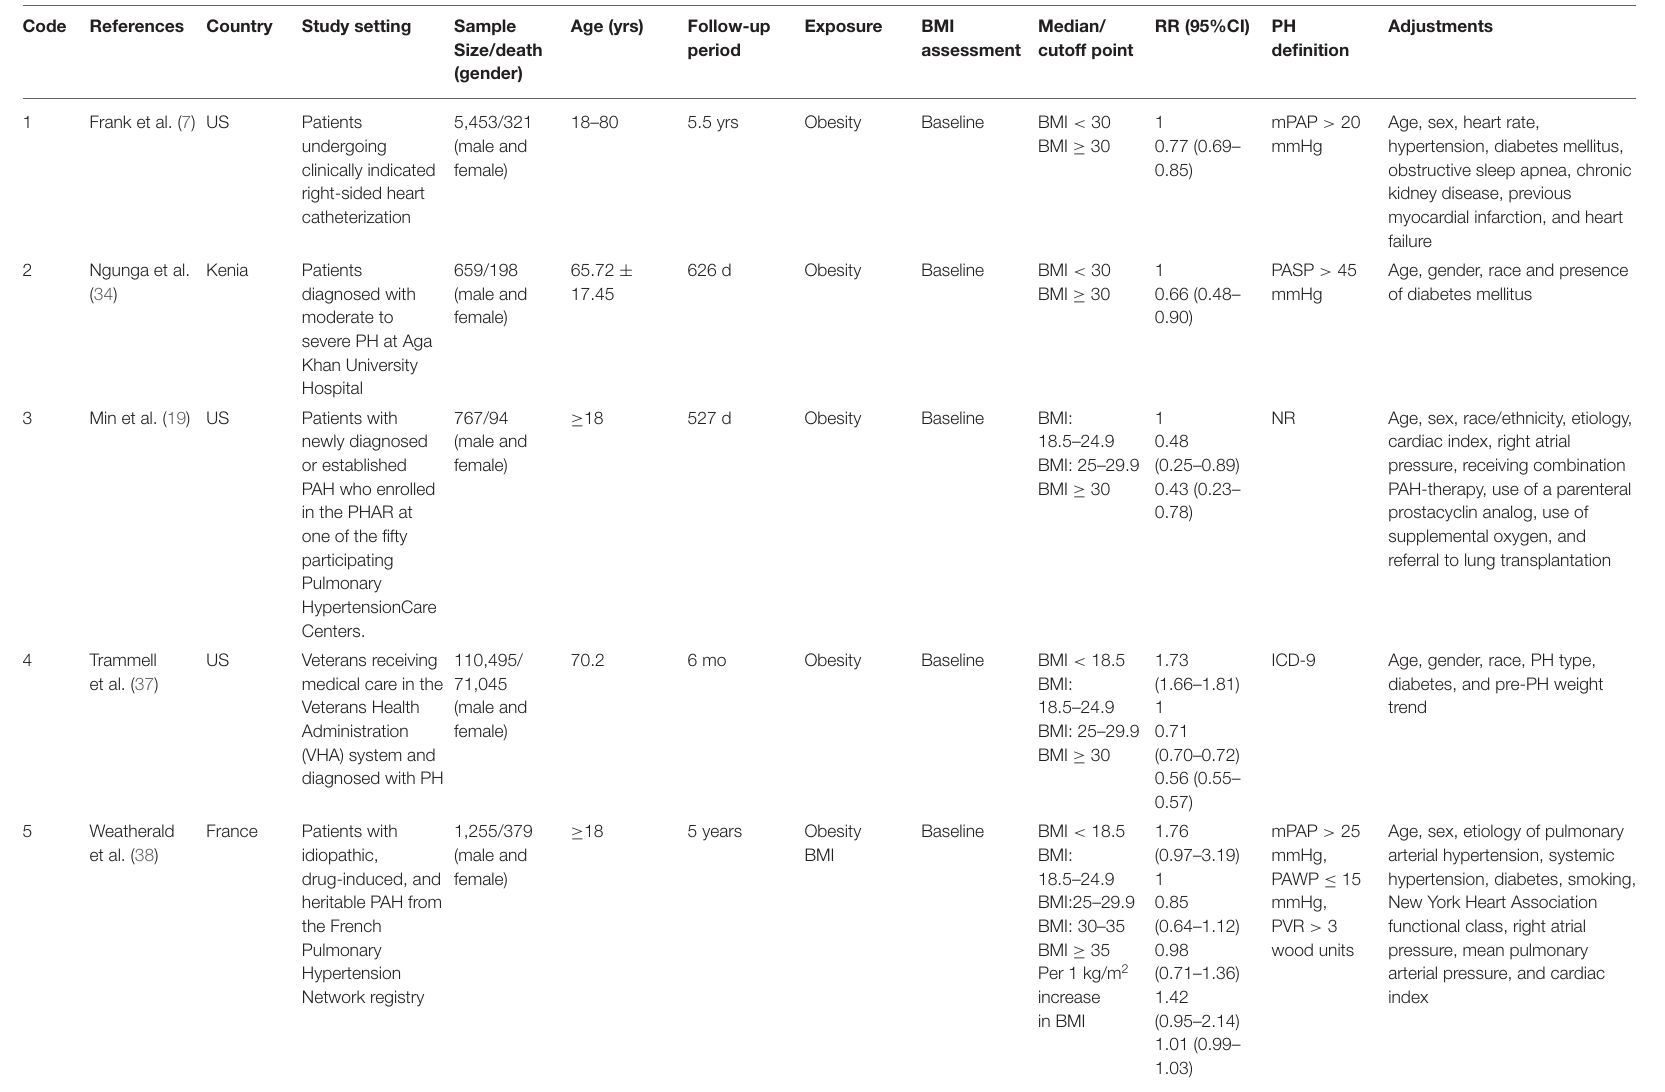
TABLE 1 | Characteristics of cohort studies eligible in the systematic review and